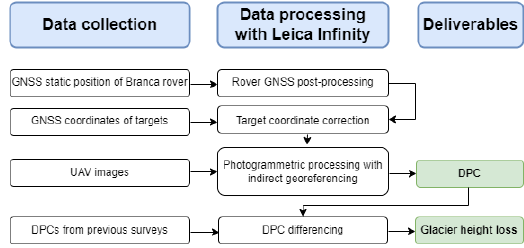
Figure 3. Processing flowchart based on a standard photogrammetric pipeline.